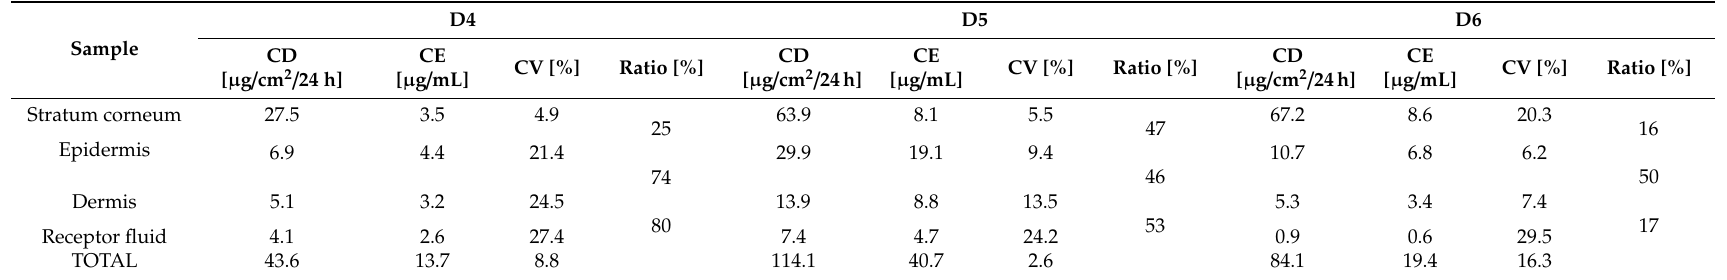
Table 5. The cumulative doses (CD) of D4, D5, and D6 in various layers of the skin and in receptor fluid; total amount after di ff usion as well as concentration in extracts (CE); calculated epidermis-to-stratum corneum, dermis-to-epidermis, dermis-to-receptor fluid ratios. mean obtained from n = 7. D4 D5 D6 Sample CD CE CD CE CD CE CV [%] Ratio CV [%] Ratio [%] CV [%] Ratio [%] [ µ g / cm 2 / 24h] [ µ g / mL] [ µ g / cm 2 / 24h] [ µ g / mL] [ µ g / cm 2 / 24 h] [ µ g / mL]